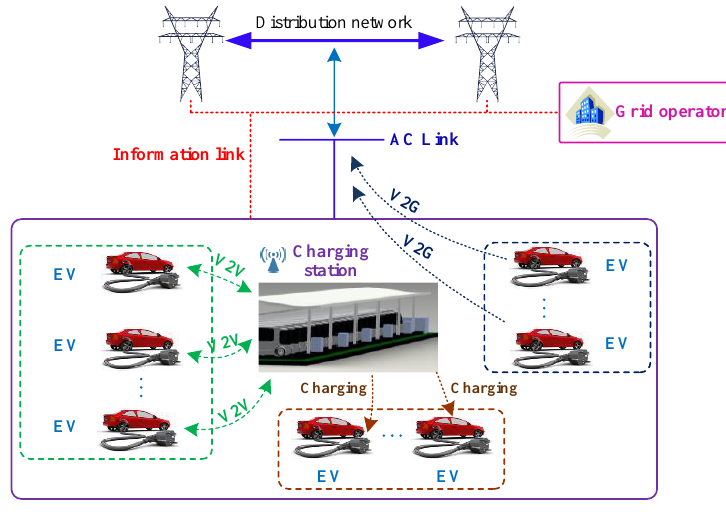
Figure 4. Paradigm of V2V.